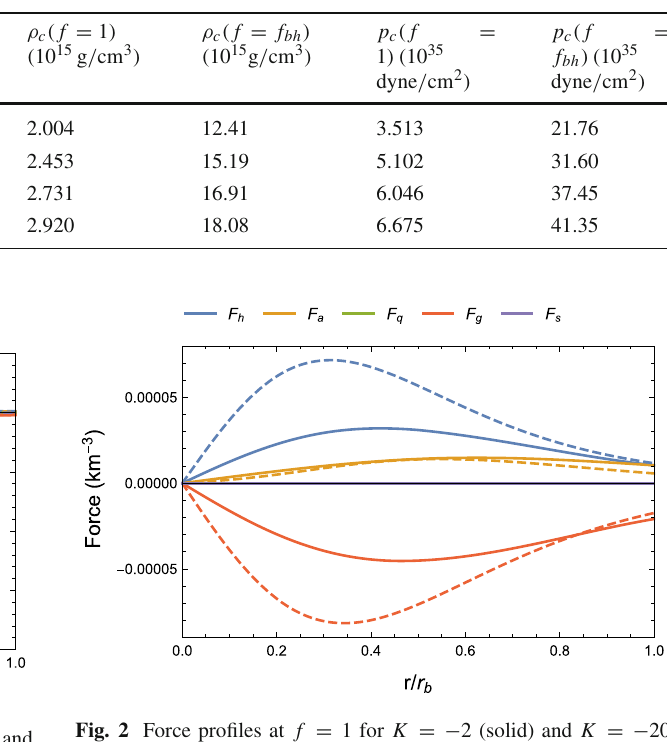
Fig. 1 Temporal progression of surface forces for K = − 2 (solid) and K = − 20 (dashed)